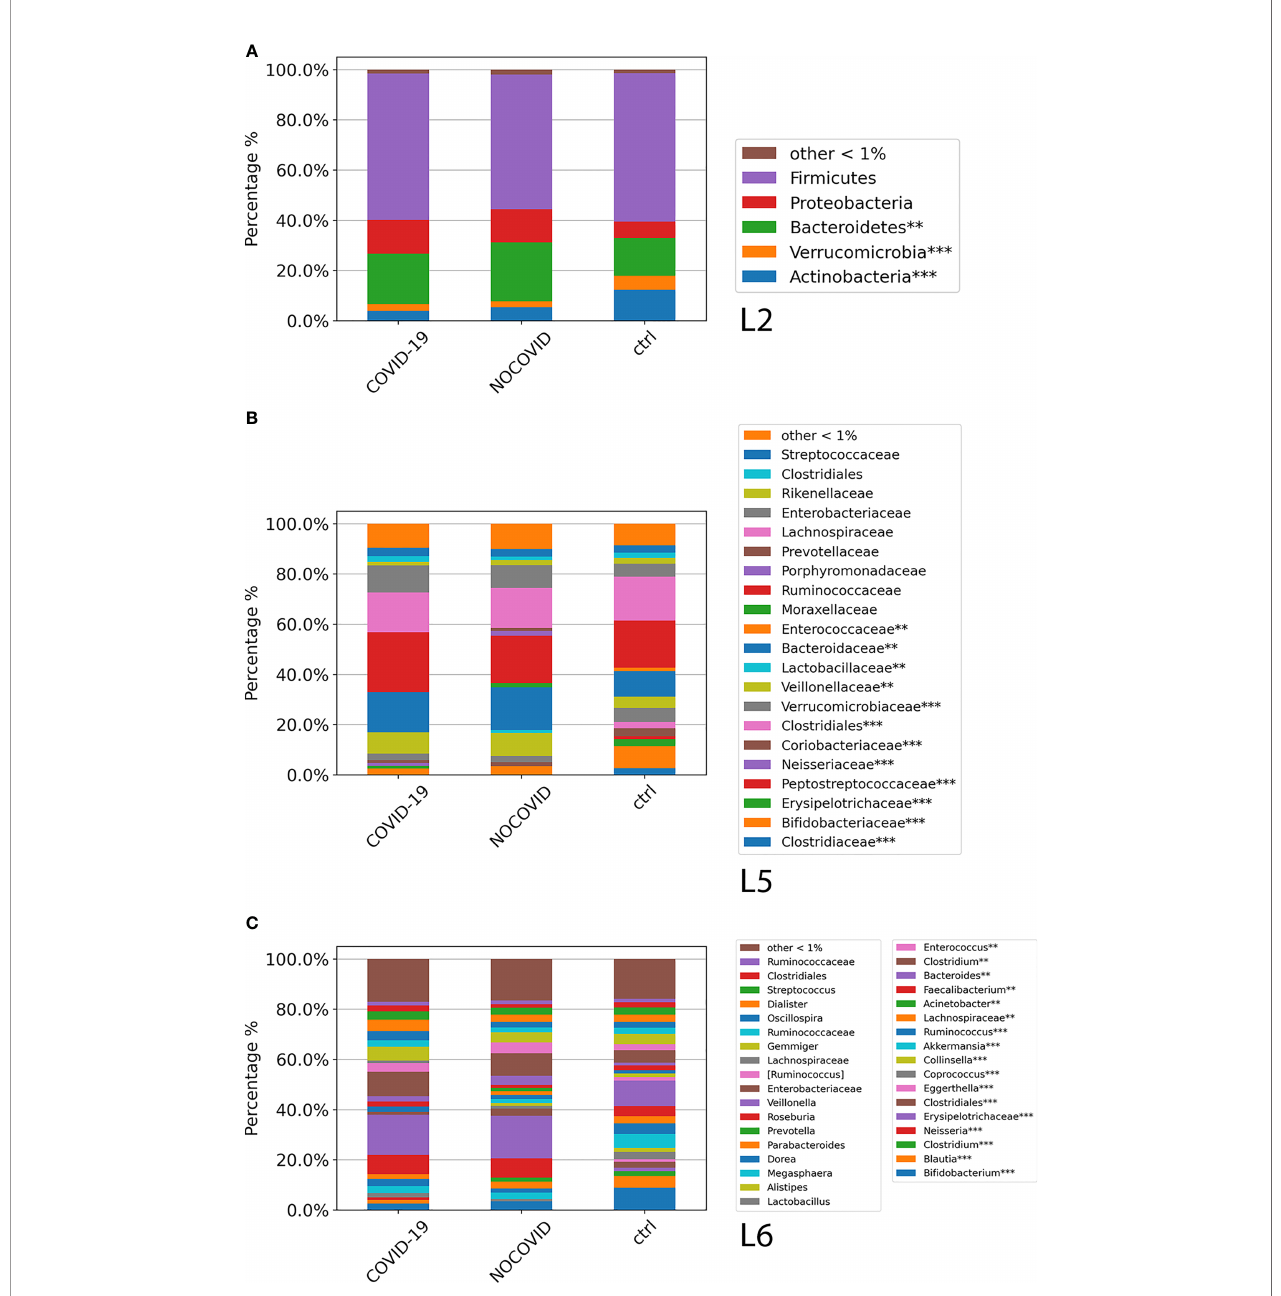
FIGURE 3 | ASV distributions of COVID-19 and Non – COVID-19 cohorts and CTRLs at L2 (A) , L5 (B) , and L6 (C) , fi ltered by statistically signi fi cance based on the Kruskal – Wallis test. * p -value < 0.001; p -value **FDR < 0.05; *** p -value FDR <